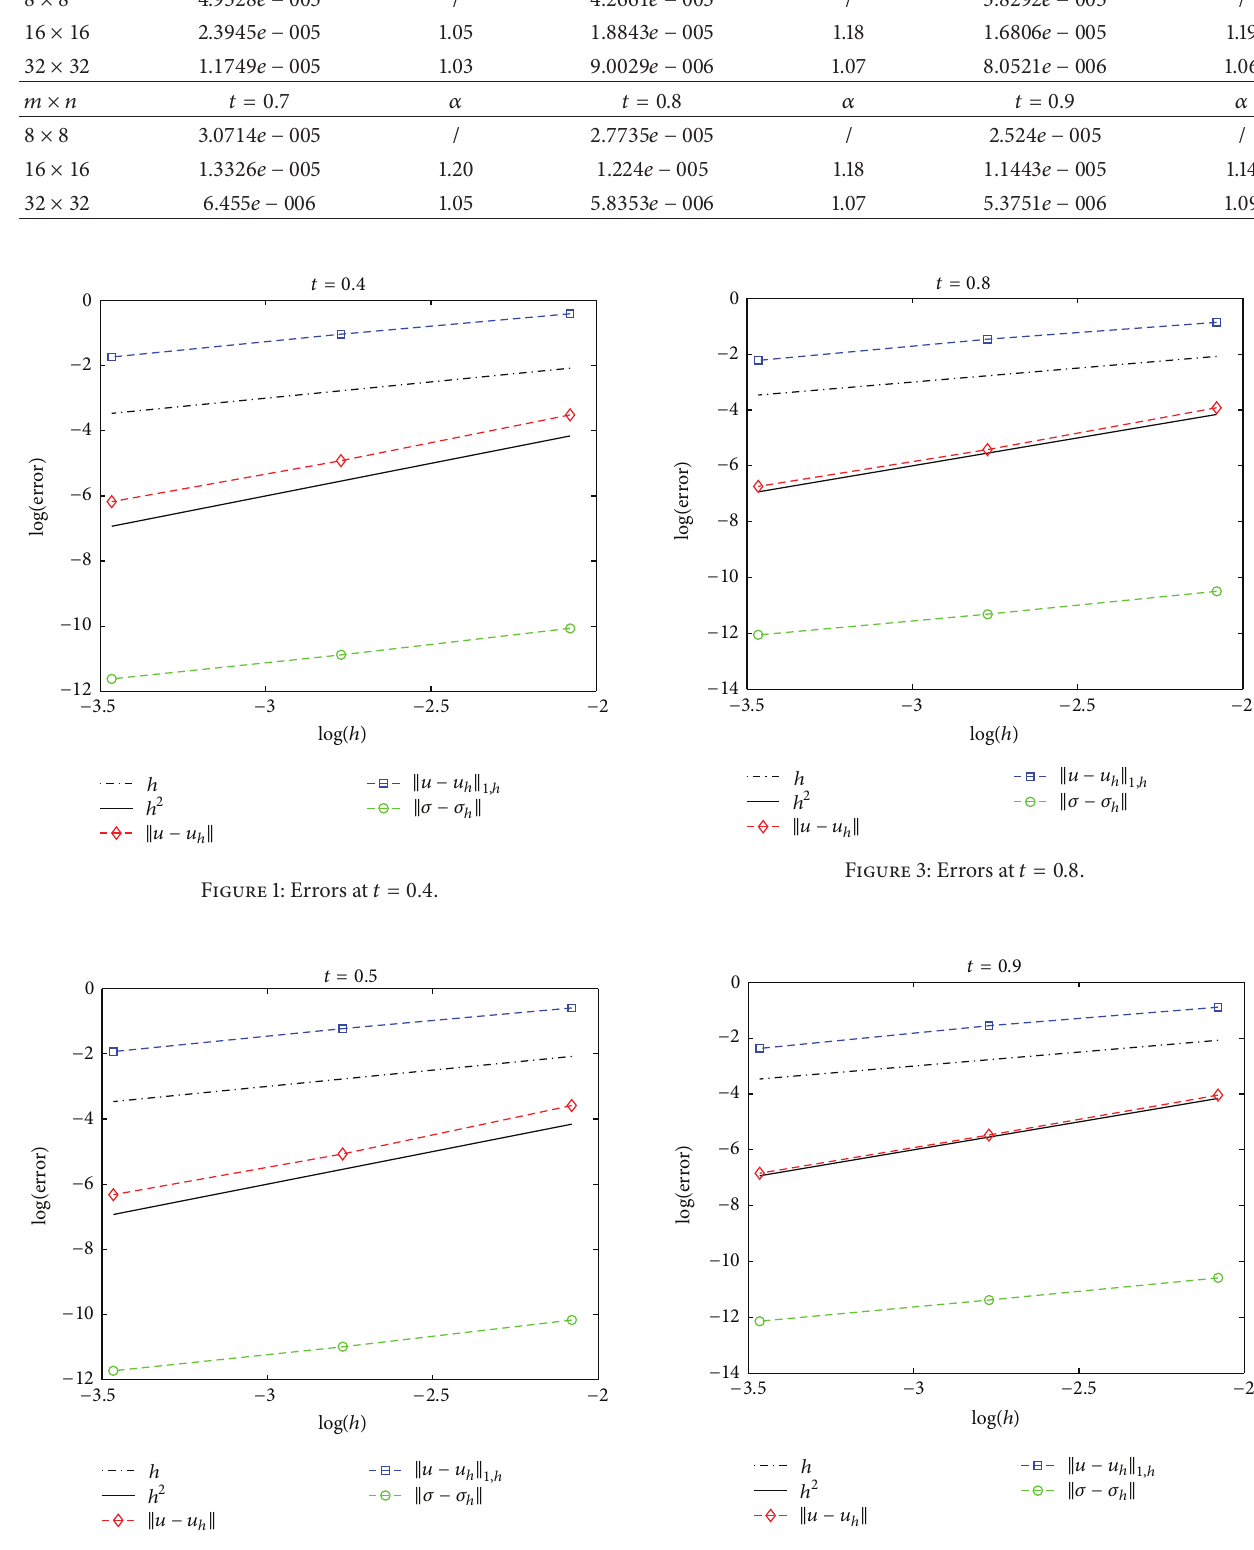
Figure 4: Errors at 𝑡 = 0.9